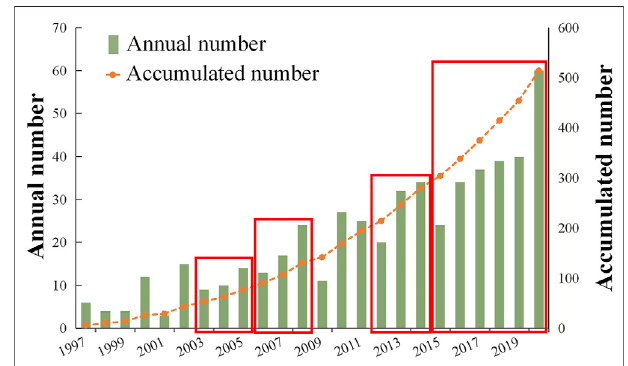
FIGURE 2 | Annual number and accumulated number of Catha edulis publications from 1997 to 2020.